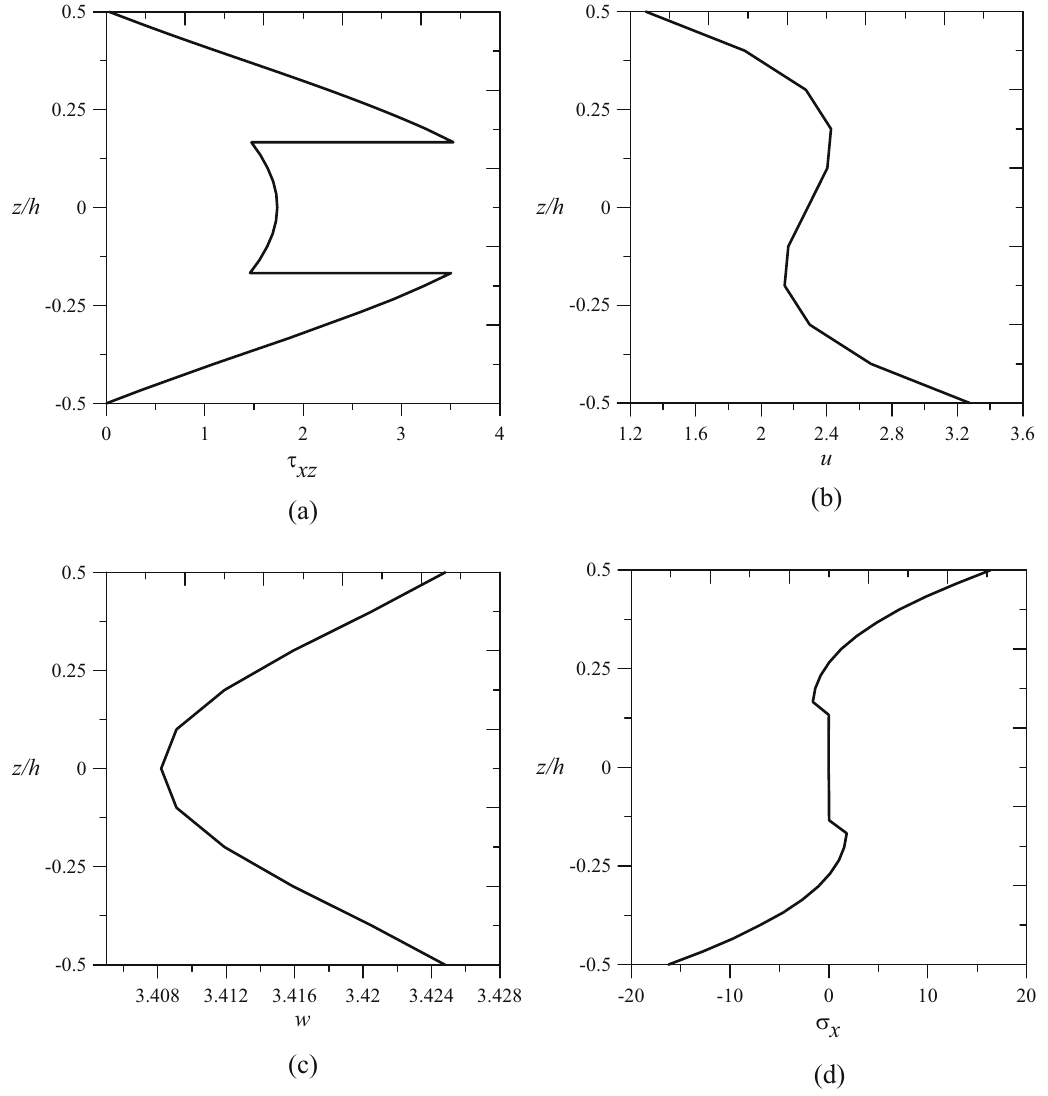
Figure 3: Variation through the thickness for transverse shear stresses ( a ) , axial displacements ( b ) , transverse displacements ( c ) , and axial bending stresses ( d ) for symmetric three layered ( 0°/90°/0° ) composite arches subjected to UDL ( R / h = 5; L / h = 4 )